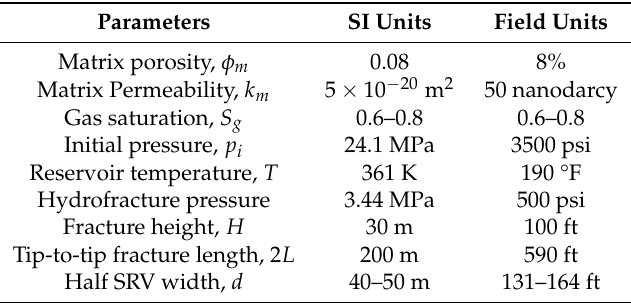
Table 1. Values of key parameters used in the